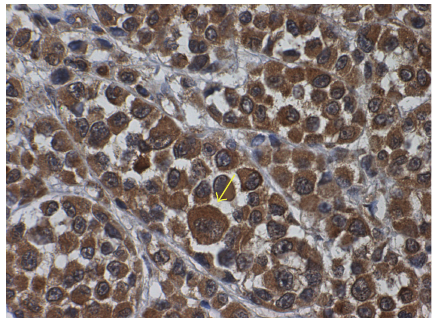
Figure 1: Immunohistochemical staining of the NK-1 receptor in a primary invasive malignant melanoma. A high expression of NK-1 receptor (arrow) was observed in the cytoplasm of the tumor cells. Cell nuclei were counterstained with hematoxylin (x